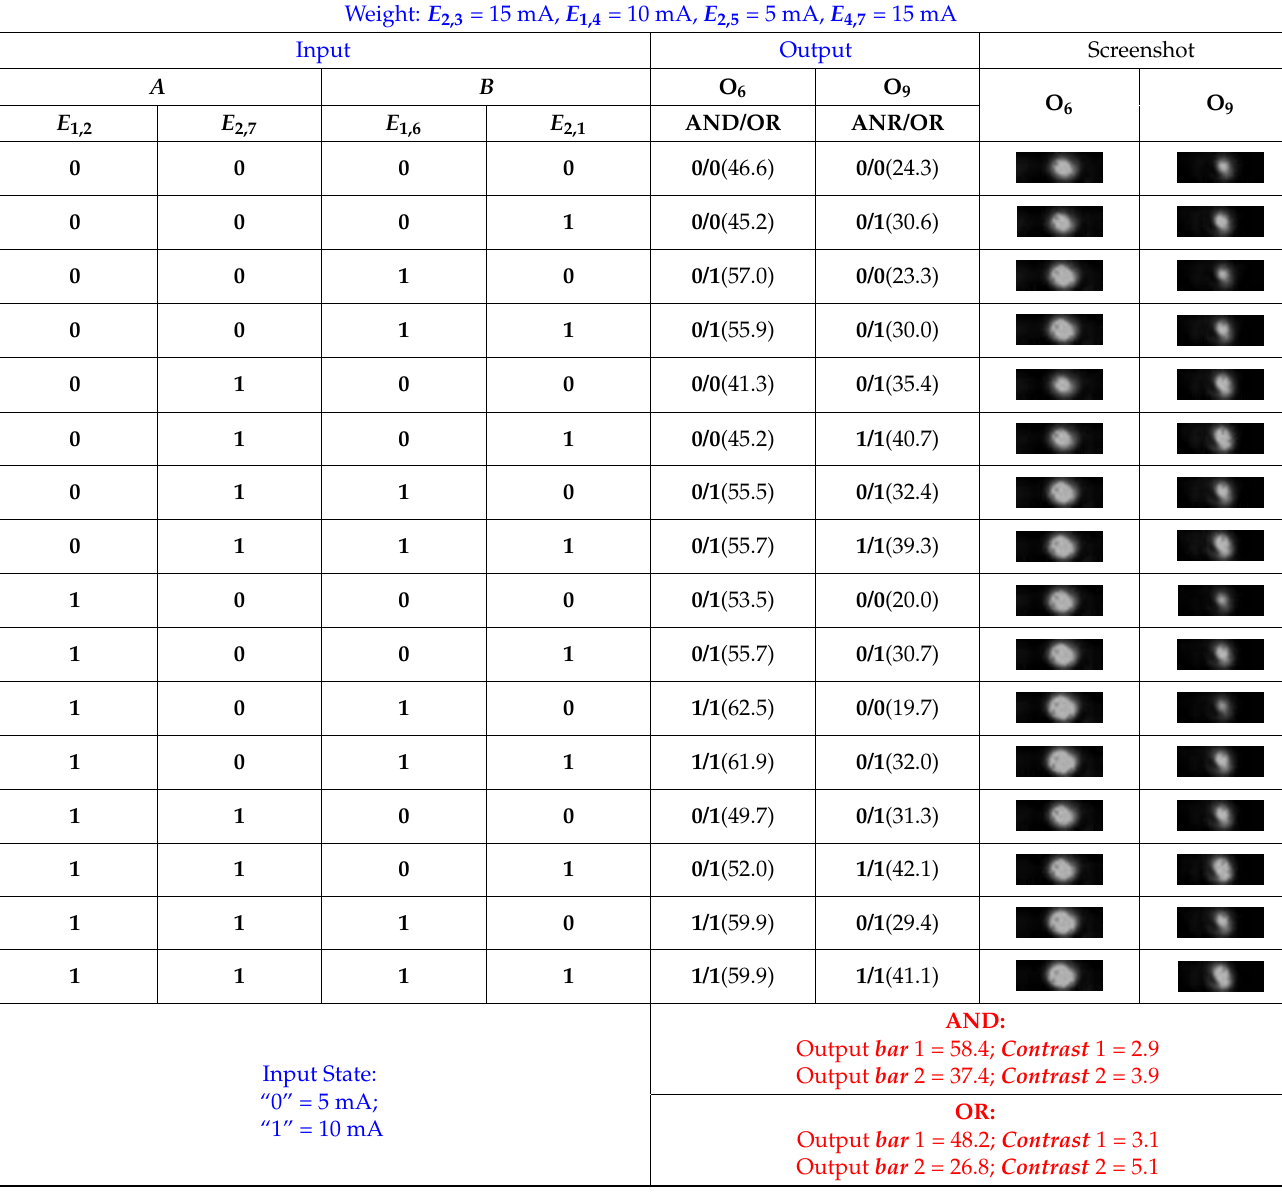
Table 4. AND and OR gate settings of S-IV. [Input- = , Weight- = , Output- = ] . S-IV: